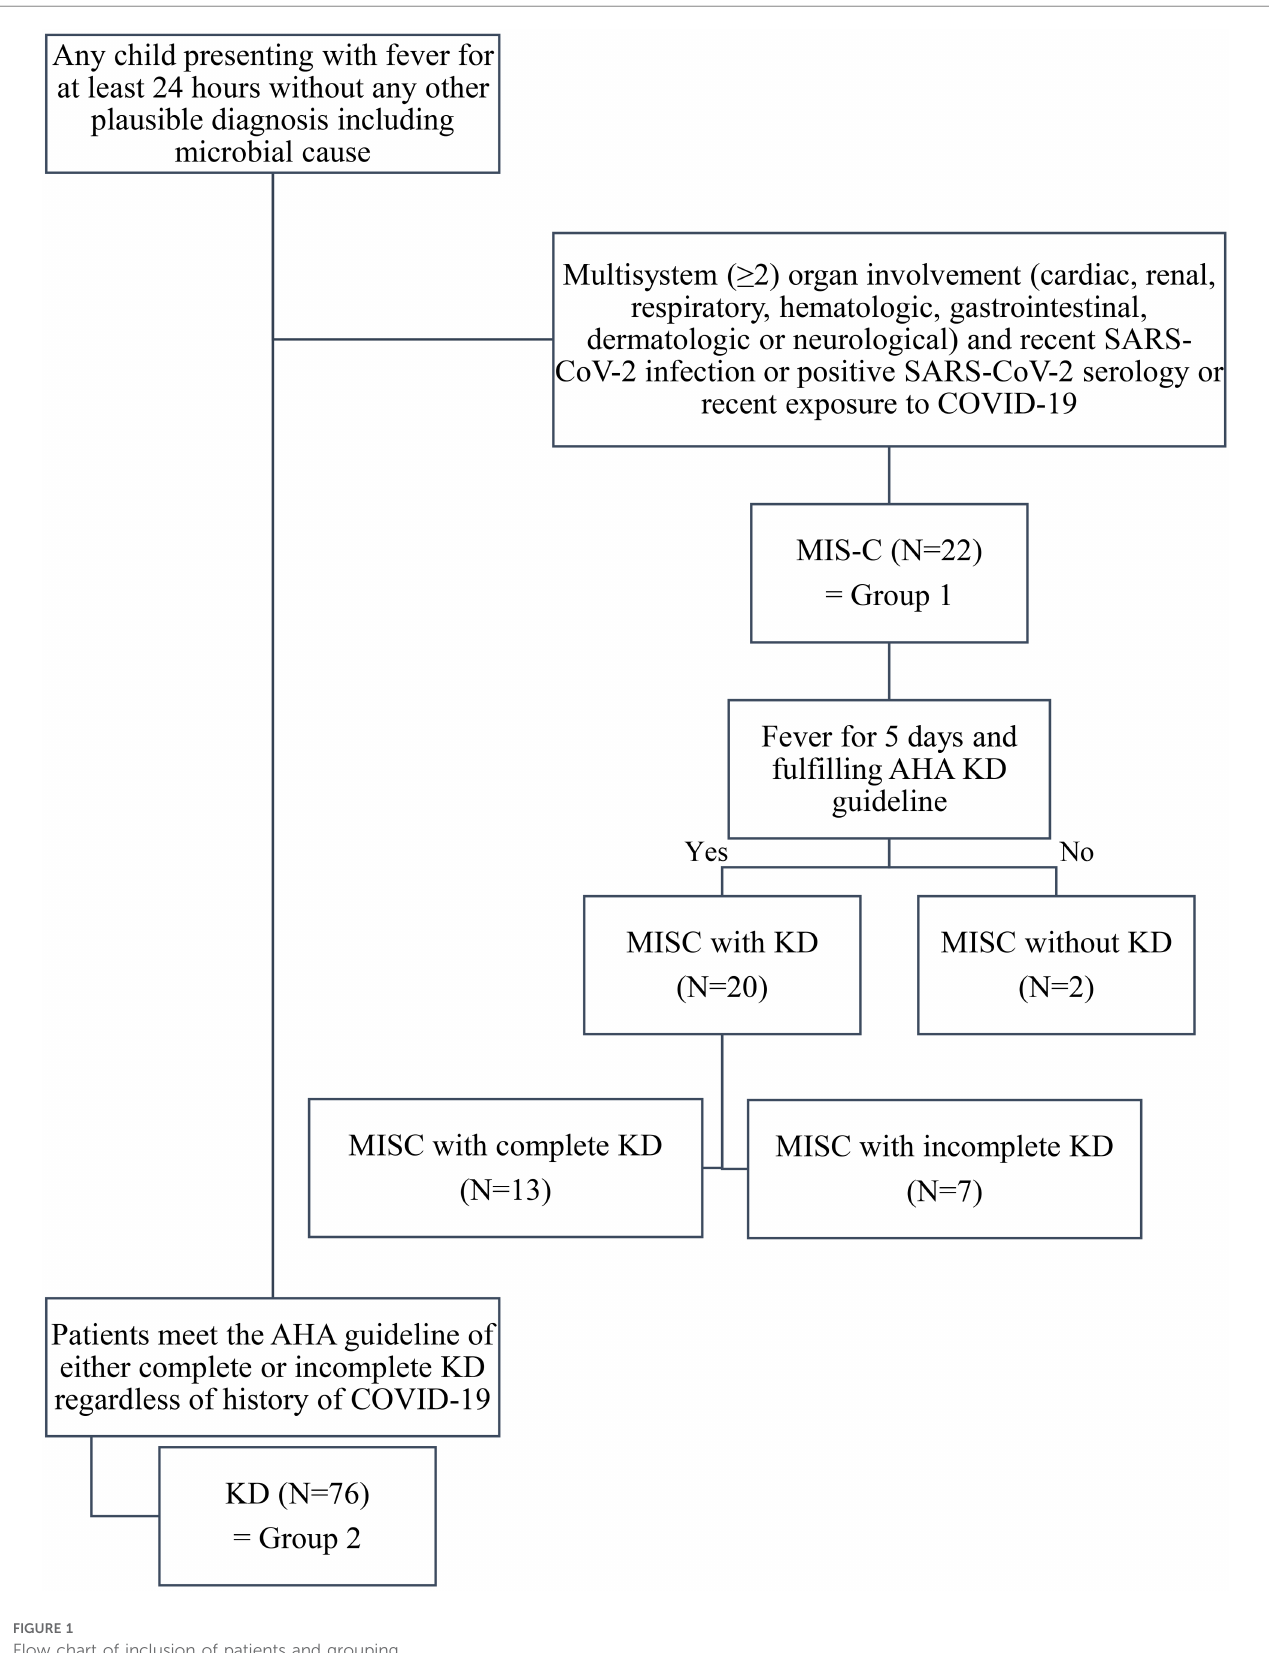
FIGURE 1 Flow chart of inclusion of patients and